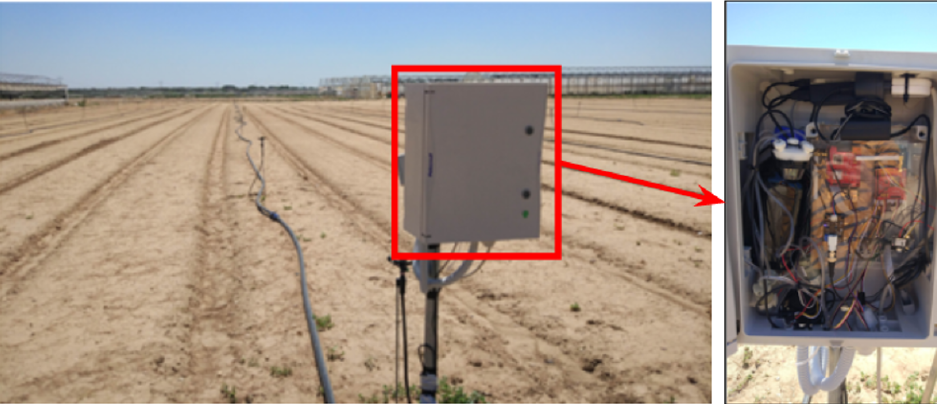
Figure 4. Photo of the monitoring prototype installed in a test